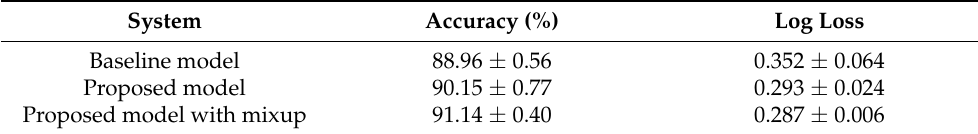
Table 4. Performance of the models on DCASE2020 Task 1b